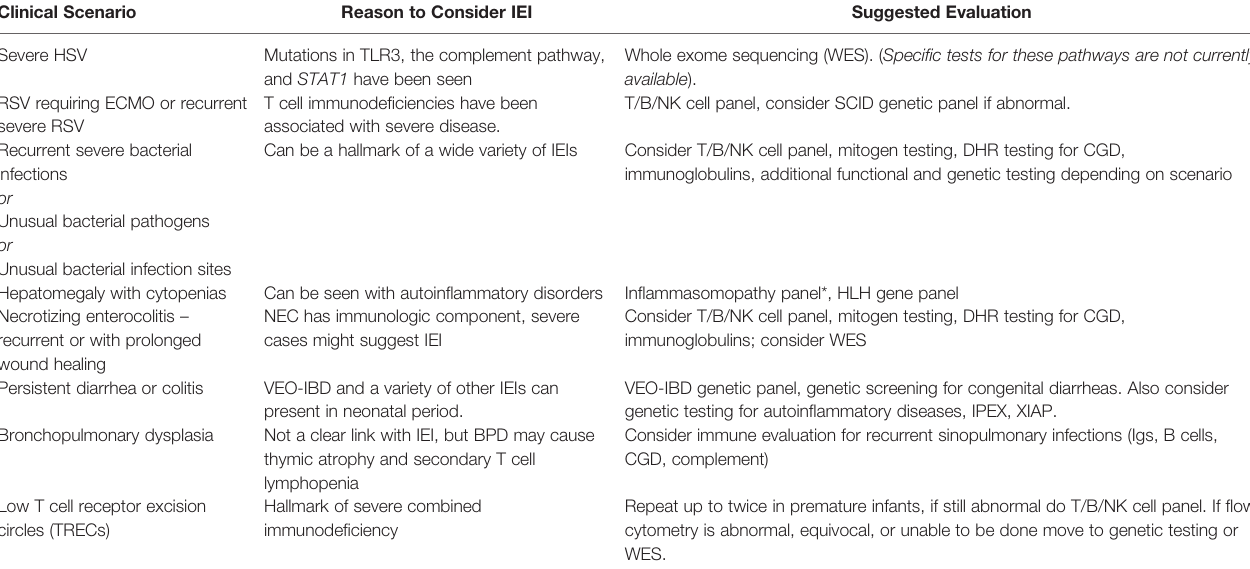
TABLE 1 | Features of prematurity that may suggest